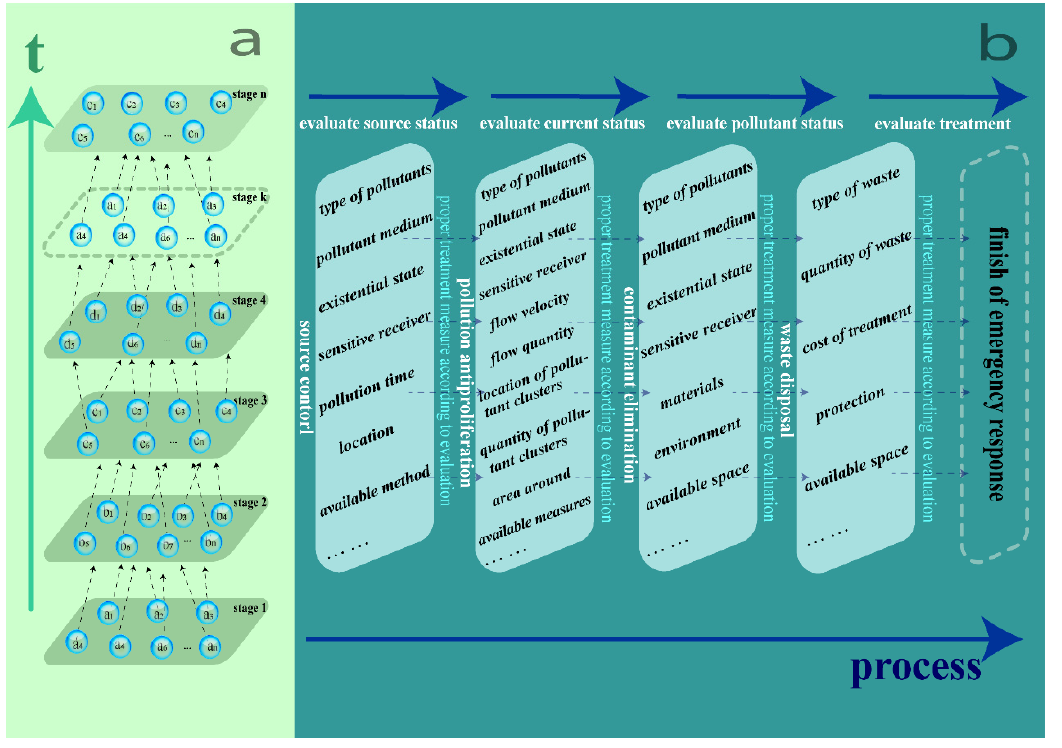
Figure 4. Evolution process over time ( a ) and the flow of emergency response measures ( b ).